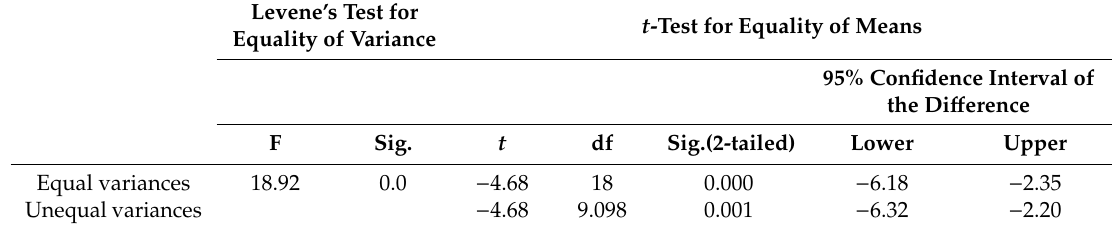
Table 11. t -test statistics with survey